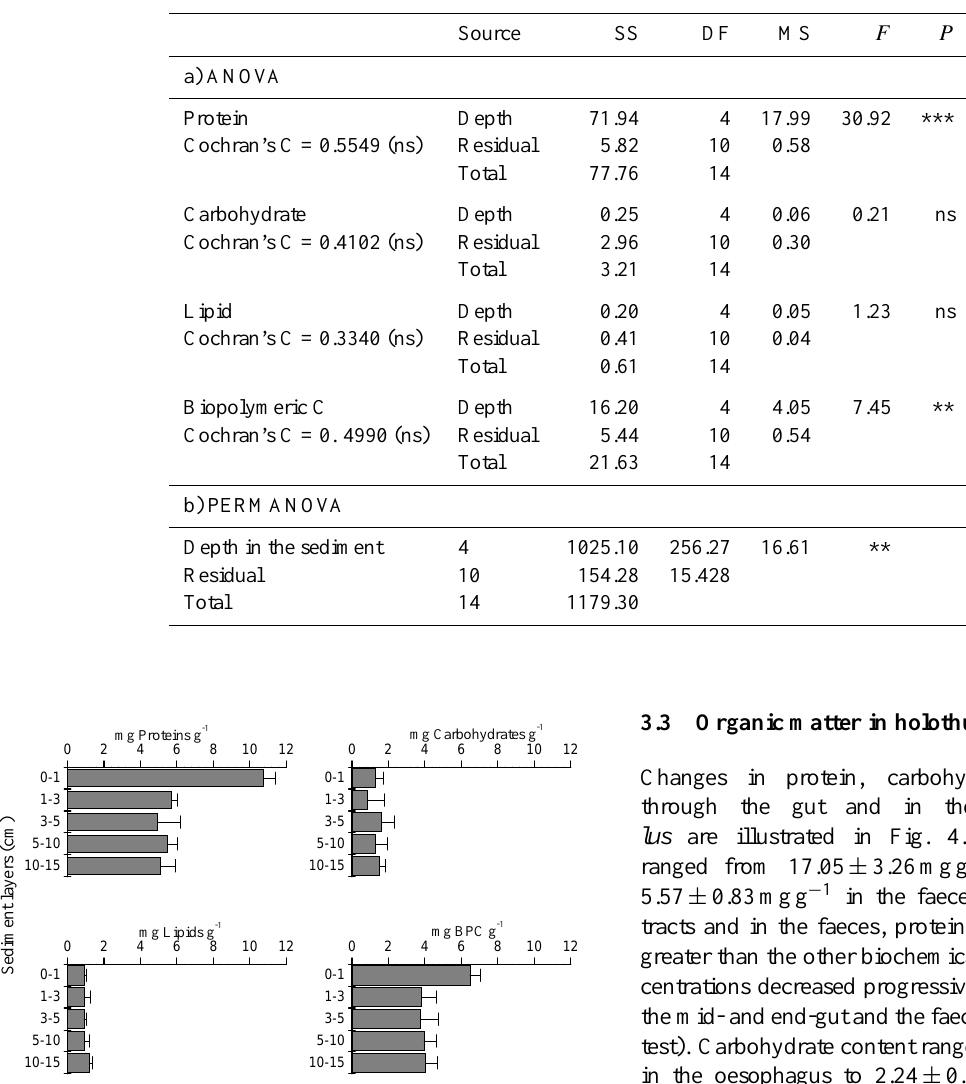
(Table 2). As for the different classes of organic compounds, no significant differences were observed between the layers from 1 to 15 cm depth in the sediment